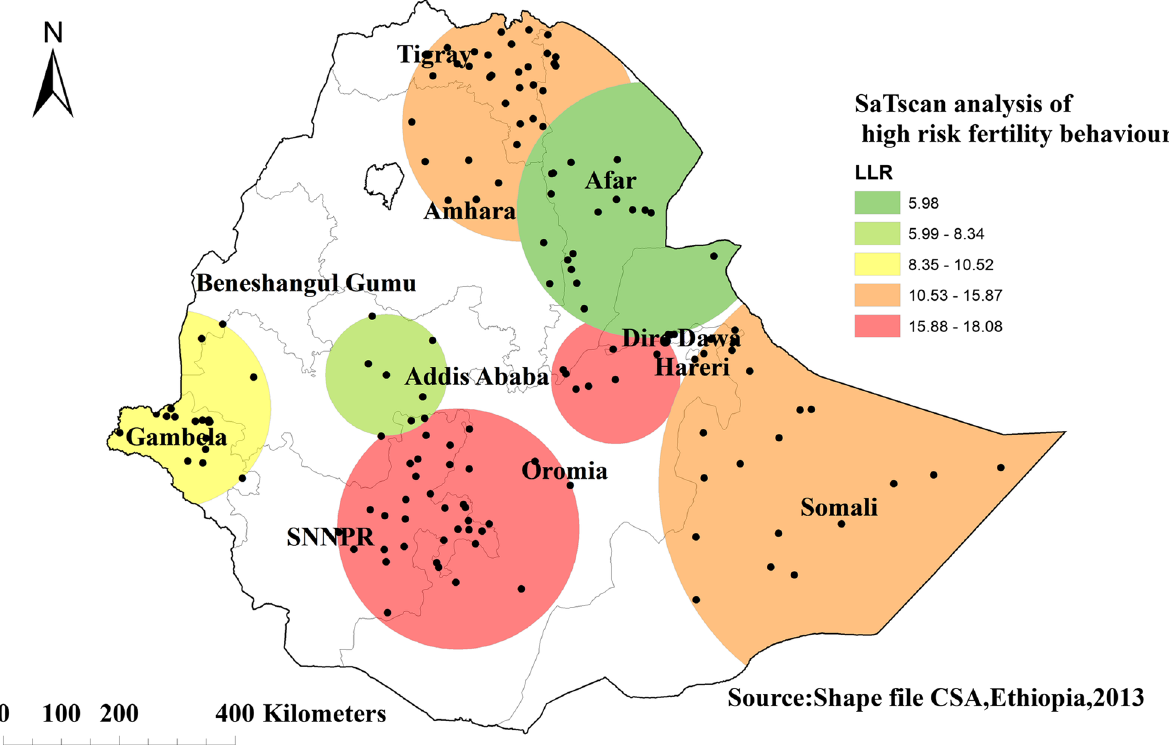
Fig. 5 Spatial scan statistics analysis of high-risk fertility behavior among reproductive-age women in Ethiopia, 2019 Ethiopian Demographic and Health Survey